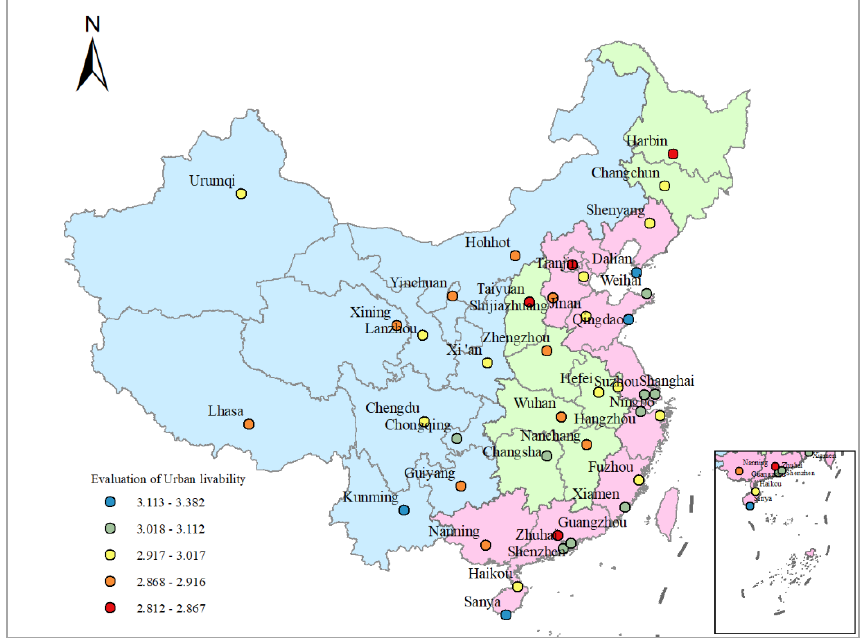
Figure 3. Evaluation of Urban liveability. These maps were drawn according to the standard map with the drawing No. GS (2019) 1673, which was downloaded from the standard map service website of the Ministry of Natural Re-sources of the People’s Republic of China. No modifications were made on the base map.